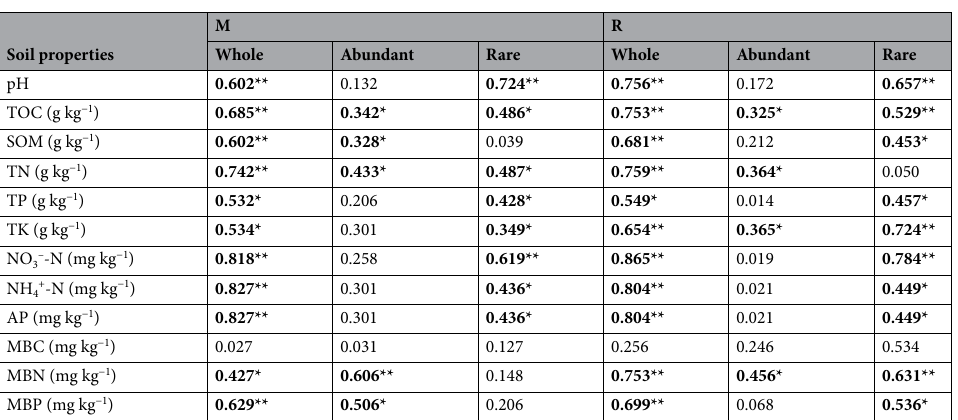
Table 5. Spearman’s correlations of soil microbial community and physiochemical factors in different cropping patterns of tobacco, based on Mantel tests. TOC total organic carbon, SOM soil organic matter, TN total nitrogen, TP total phosphorus, TK total potassium, NO 3 – -N nitrate nitrogen, NH 4 + -N ammonium nitrogen, AP available phosphorus, MBC microbial biomass carbon, MBN microbial biomass nitrogen, MBP microbial biomass phosphorus, M tobacco monoculture, R tobacco-rice rotation, Whole whole bacterial communities, Abundant abundant taxa, Rare rare taxa. Bold text indicates statistical significance. *P < 0.05 significance level. **P < 0.01 significance level. ****P < 0.001 significance